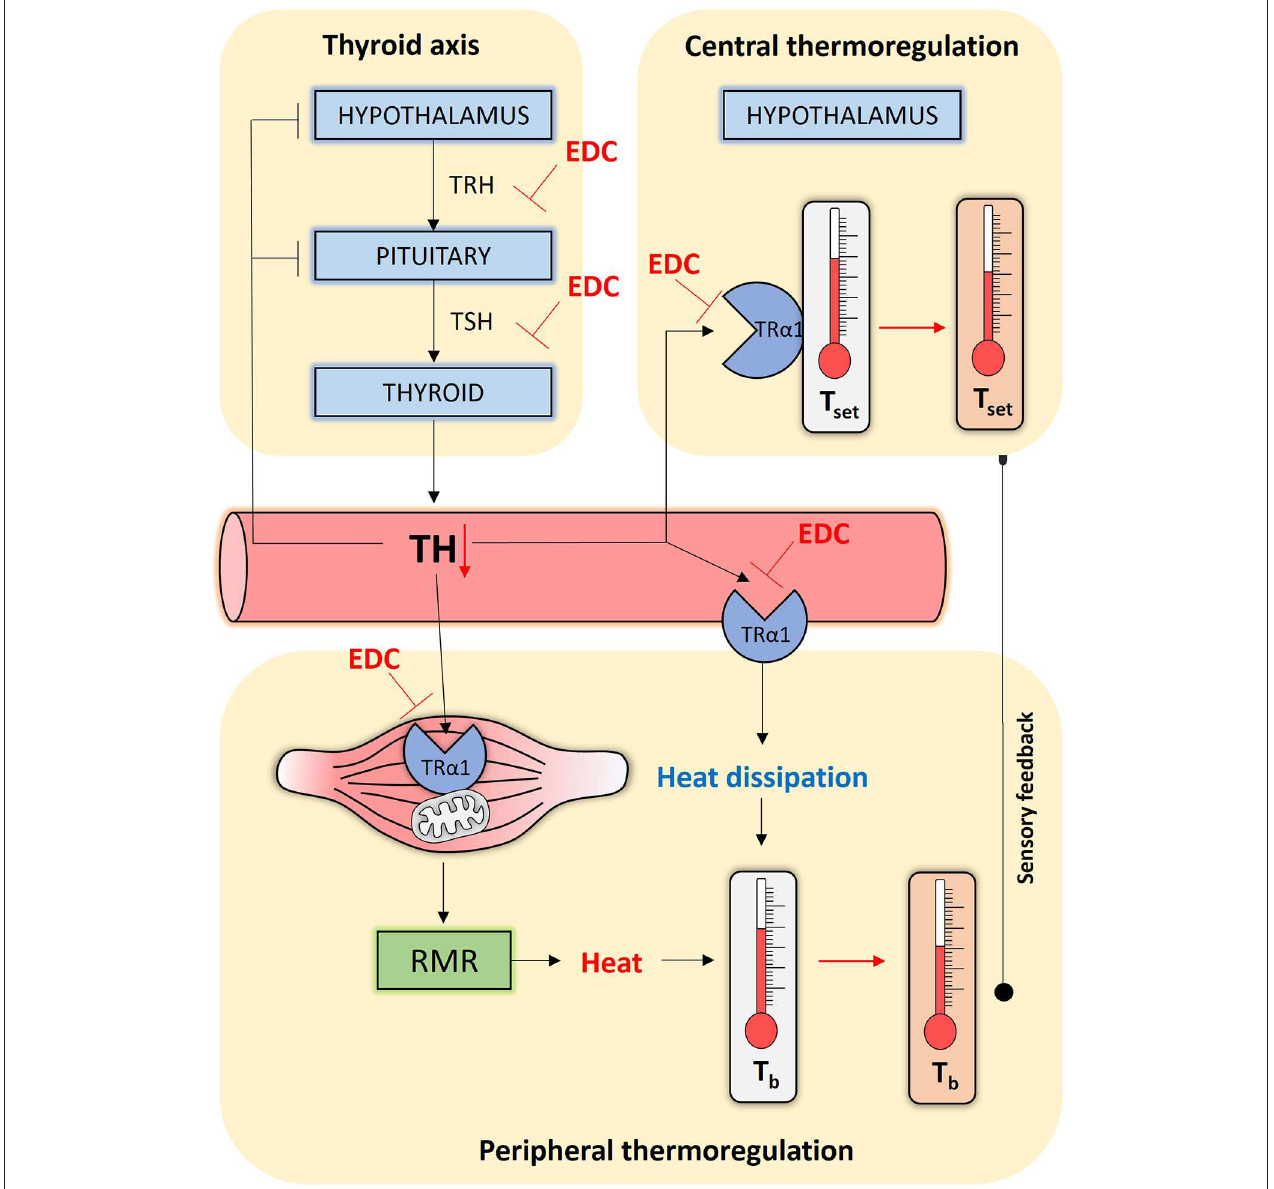
FIGURE 1 | Simplified scheme of how endocrine disrupting chemicals (EDCs) might interfere with human thermoregulation. The Hypothalamic-Pituitary-Thyroid (HPT) axis, or thyroid axis, consists of neurons synthesizing thyrotropin-releasing hormone (TRH) that stimulates thyrotropes in the pituitary to release thyrotropin (TSH). TSH stimulates the thyroid gland to produce and secrete the thyroid hormones (THs), which negatively feedback at the level of the HPT axis. THs reach central and peripheral organs via the circulation. At the level of the hypothalamus, TH programs and safeguards the temperature set point (T set ). At the level of the muscle tissue, TH alters the resting metabolic rate (RMR) by acting on oxidative phosphorylation and mitochondrial biogenesis, generating heat in the process that maintains core body temperature (T b ). TH may additionally affect heat dissipation by regulating vasoconstriction. All the actions listed above, other than the thyroid axis set point, occur primarily through TR α 1. EDCs can interfere at every point in this interconnected network and disrupt TH homeostasis or interfere with the activation of TR α 1, causing impaired thermoregulation control through persistent temperature set point changes, a reduced RMR and altered heat